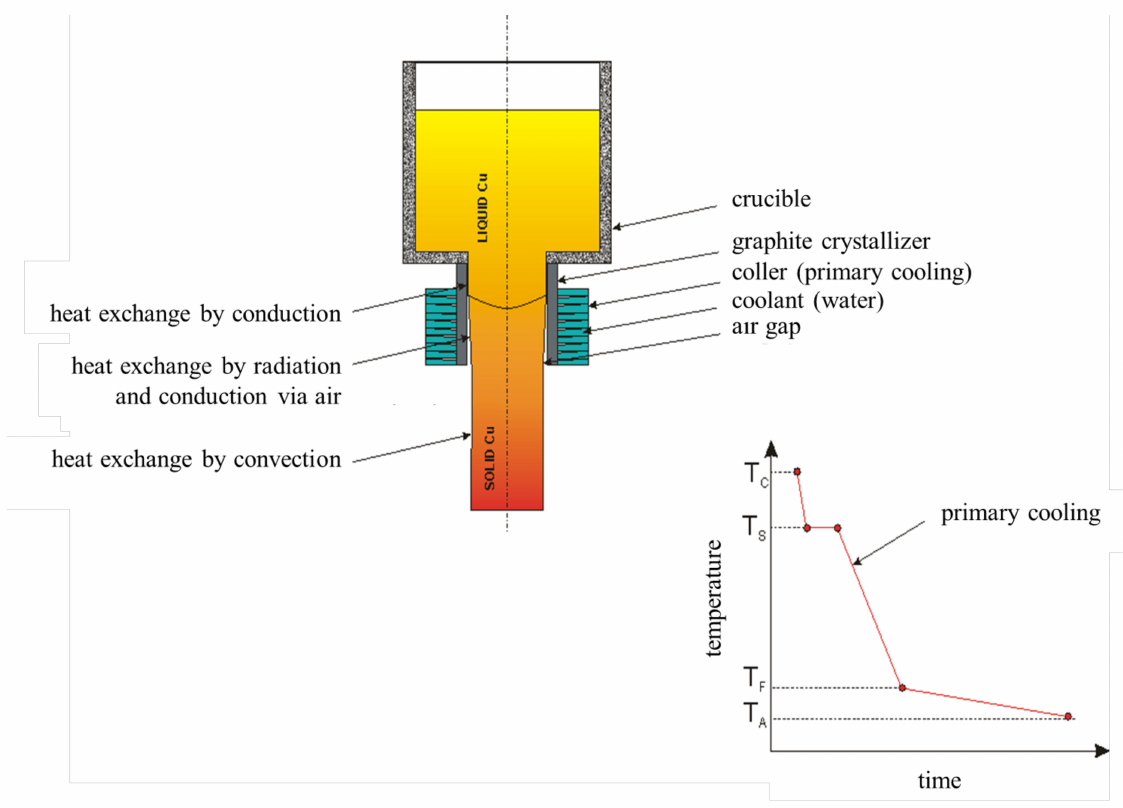
Figure 5. Schematics of the heat exchange during the continuous casting process; T C –casting temperature, T S –solidification temperature; T F –final cast rod temperature (after exiting the crystallizer); T A –ambient